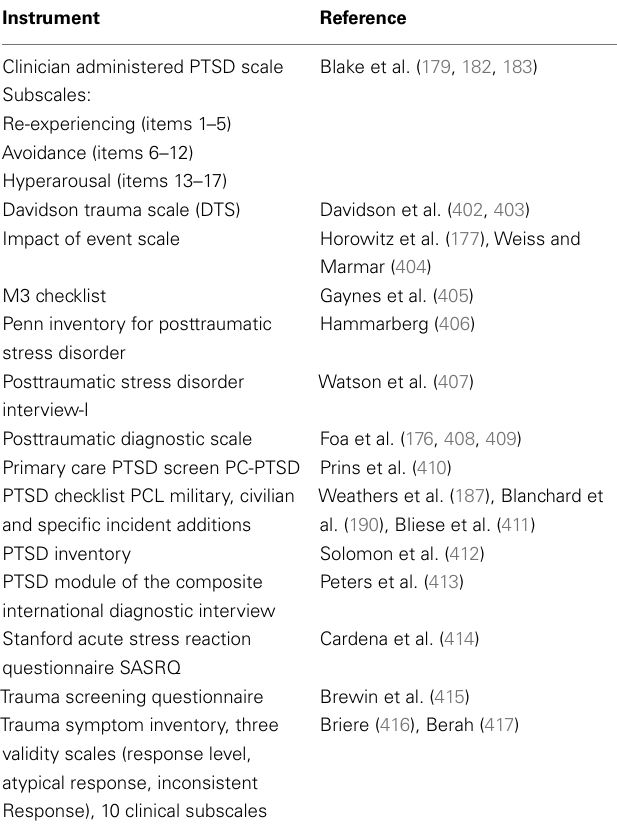
Table 9 | Instruments used in the assessment of